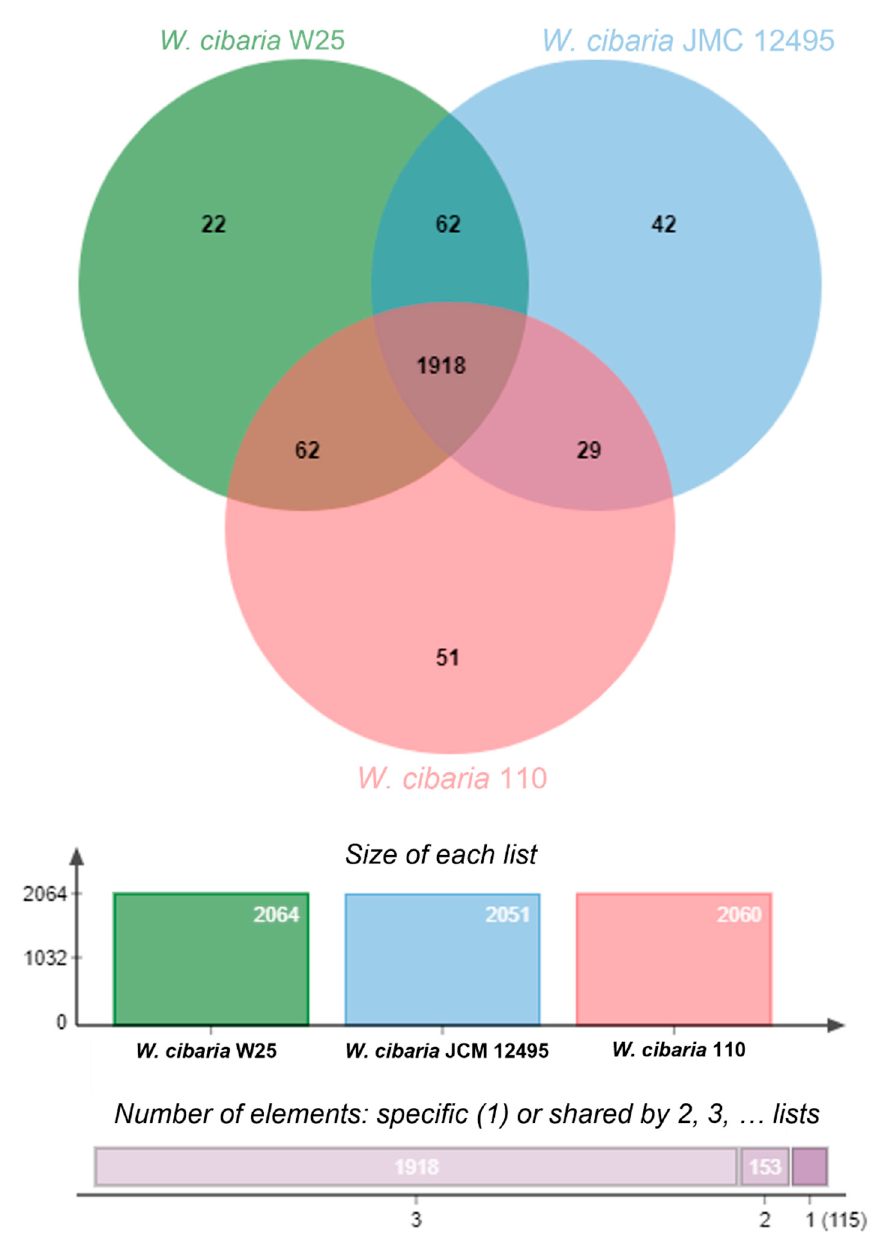
Figure 2. Venn diagram showing the protein coding genes or pseudogenes in each sequenced of W. and the numbers in the non-overlapped regions indicate the unique protein coding genes or pseudogenes.